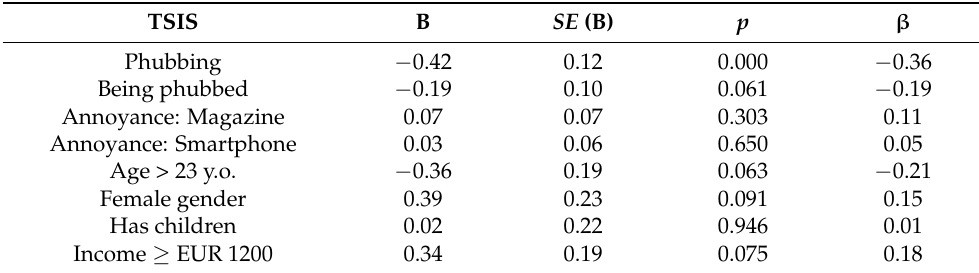
Table 3. Factors predicting social